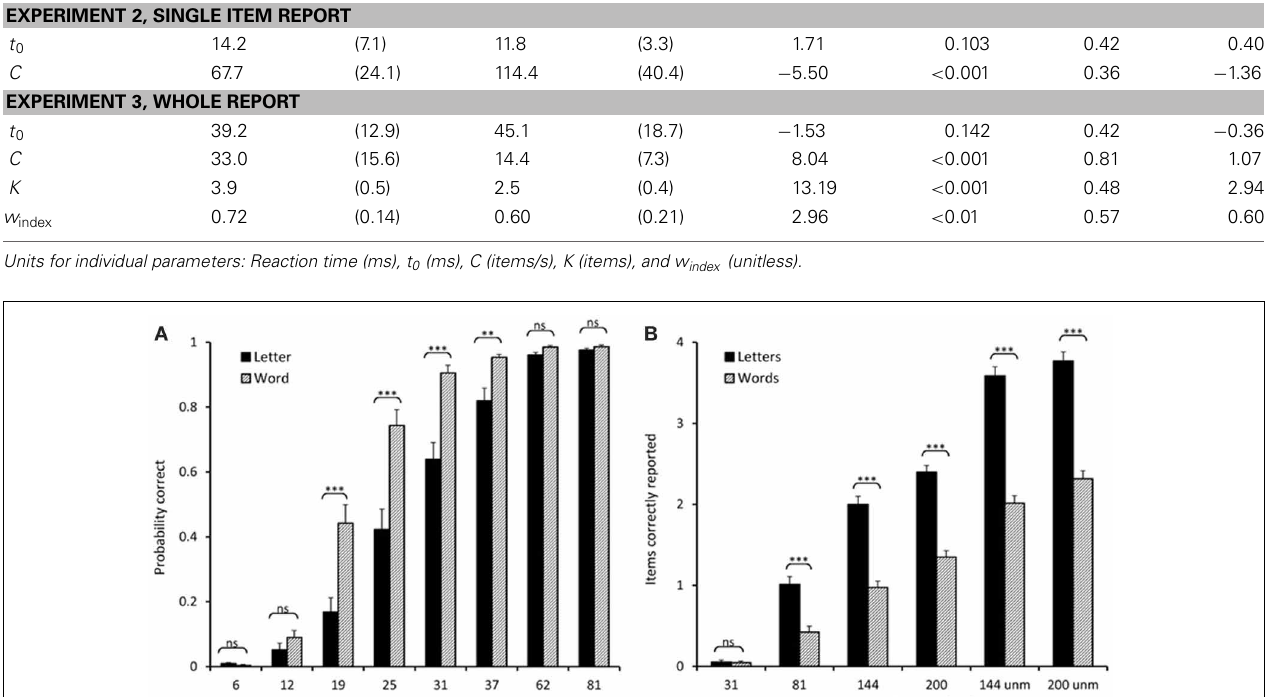
Frontiers in Human